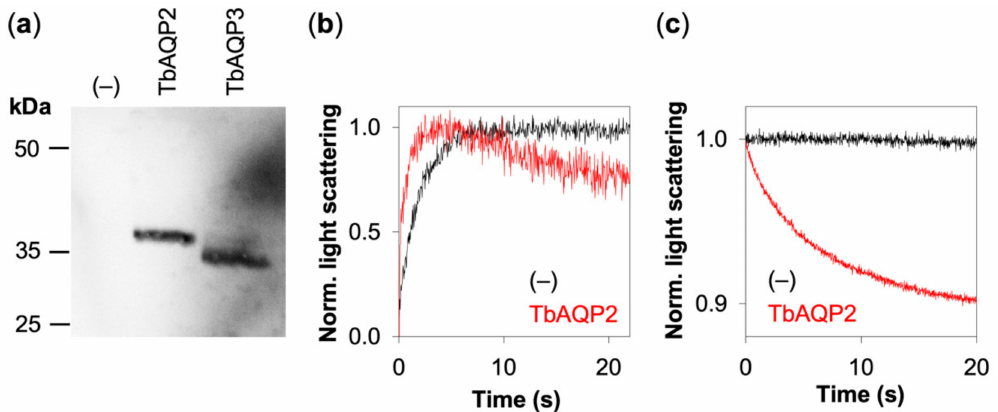
Figure 2. Expression of T. brucei aquaglyceroporins in yeast and functionality assay. ( a ) The Western blot shows TbAQP2 (35.4 kDa) and TbAQP3 (34.4 kDa) detected via an N-terminal hemagglutinin epitope tag. ( b ) Light scattering AQP functionality assay under hypertonic conditions (300 mM inward gradient of glycerol). The initial rapid phase ( < 5 s) indicates water e ffl ux and protoplast volume decreases, followed by a slower phase of volume regain upon glycerol influx. ( c ) Light scattering AQP functionality assays under isotonic conditions (300 mM inward gradient of glycerol) show a monophasic curve, indicating cell swelling due to glycerol influx. The signals shown in ( b , c ) were averaged from 6–9 traces and